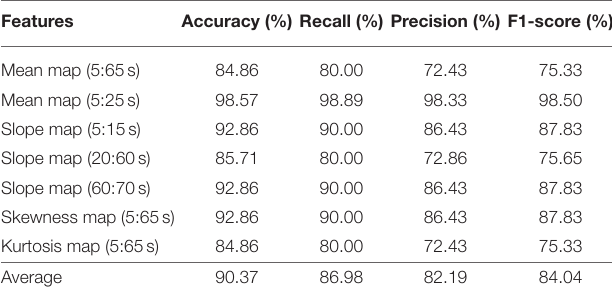
TABLE 9 | Convolutional neural network classification results of neuroimaging with temporal-spatial features for the VFT task.